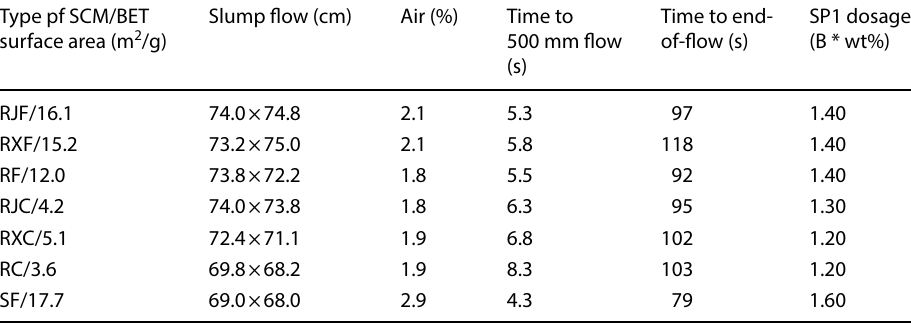
Table 7 Fresh properties and chemical admixture dosage of Series